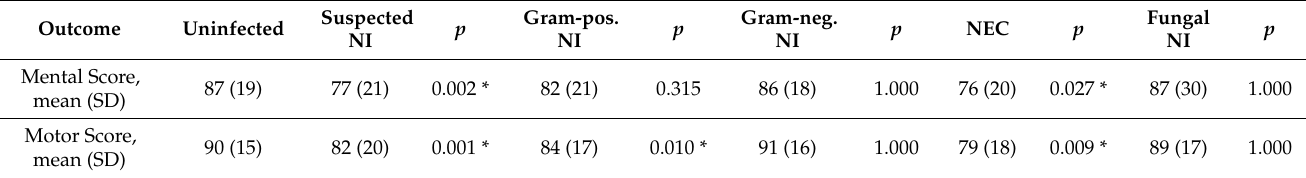
Table 2. Mental Developmental Index (MDI) and Psychomotor Development Index (PDI) mean values for specific infec- tion types.